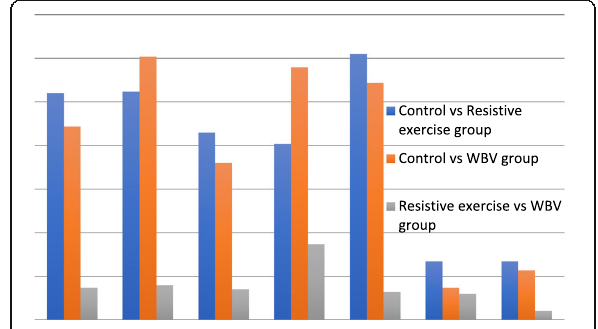
Fig. 1 Mean difference of premenstrual symptoms between all